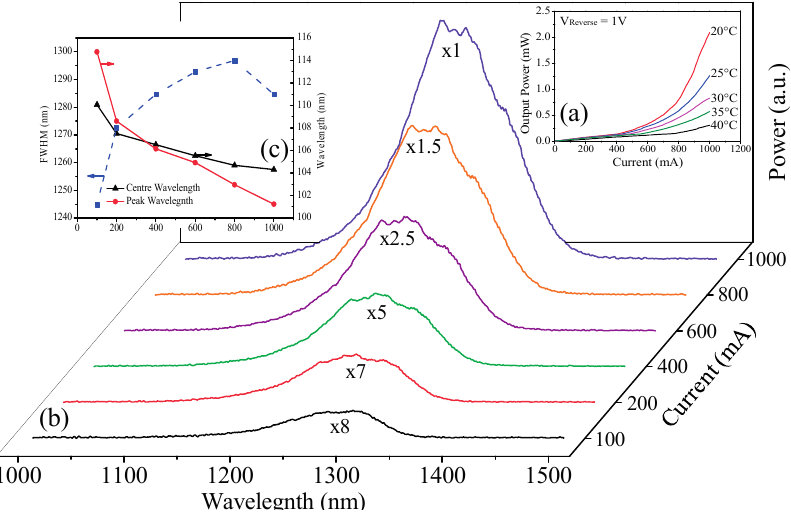
Figure 8. ( a ) Measured light-current (L-I) characteristics of the InAs/GaAs QDs SLDs on Si as a function of temperature from 20 to 40 degree. The SLD was performed by forward biased the S1 under pulsed mode, while with S2 biased at a reverse voltage of 1V. ( b ) Measured emission spectra as function different current ranging from 100mA to 1000mA, it should be note that, the intensity of power spectra are offset (spectrum peak intensity at 1000mA was taken as a reference) for clarity. ( c ) The evolution of the